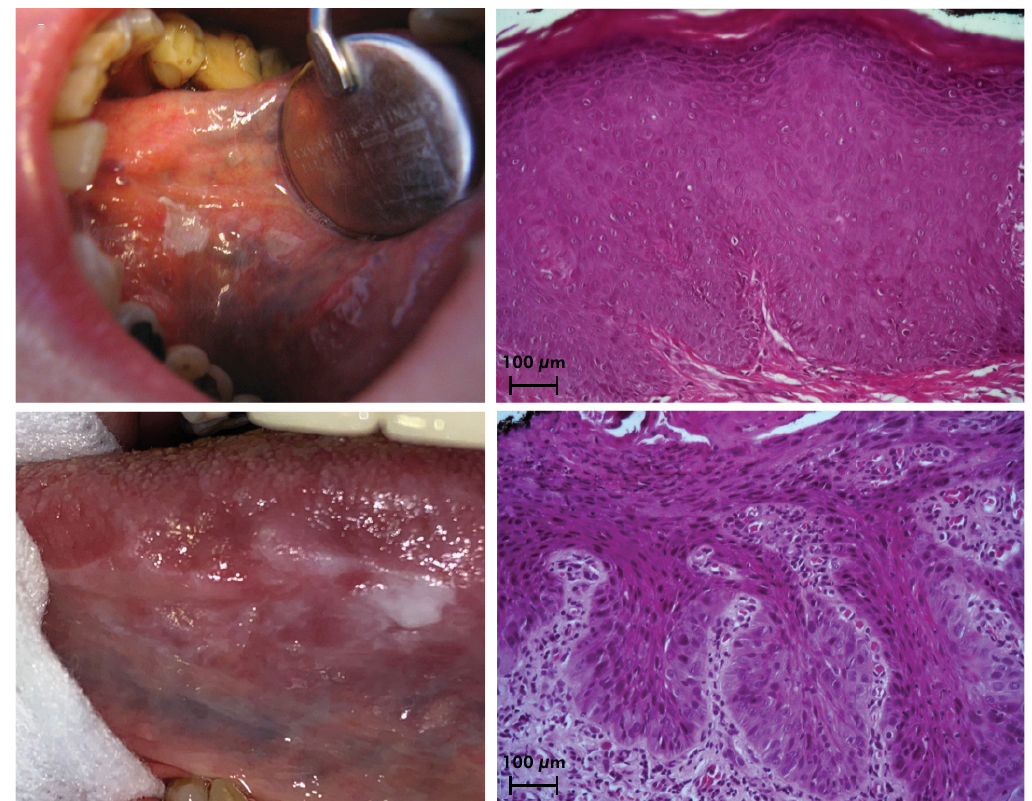
Figure 1. Representative clinical and histopathological